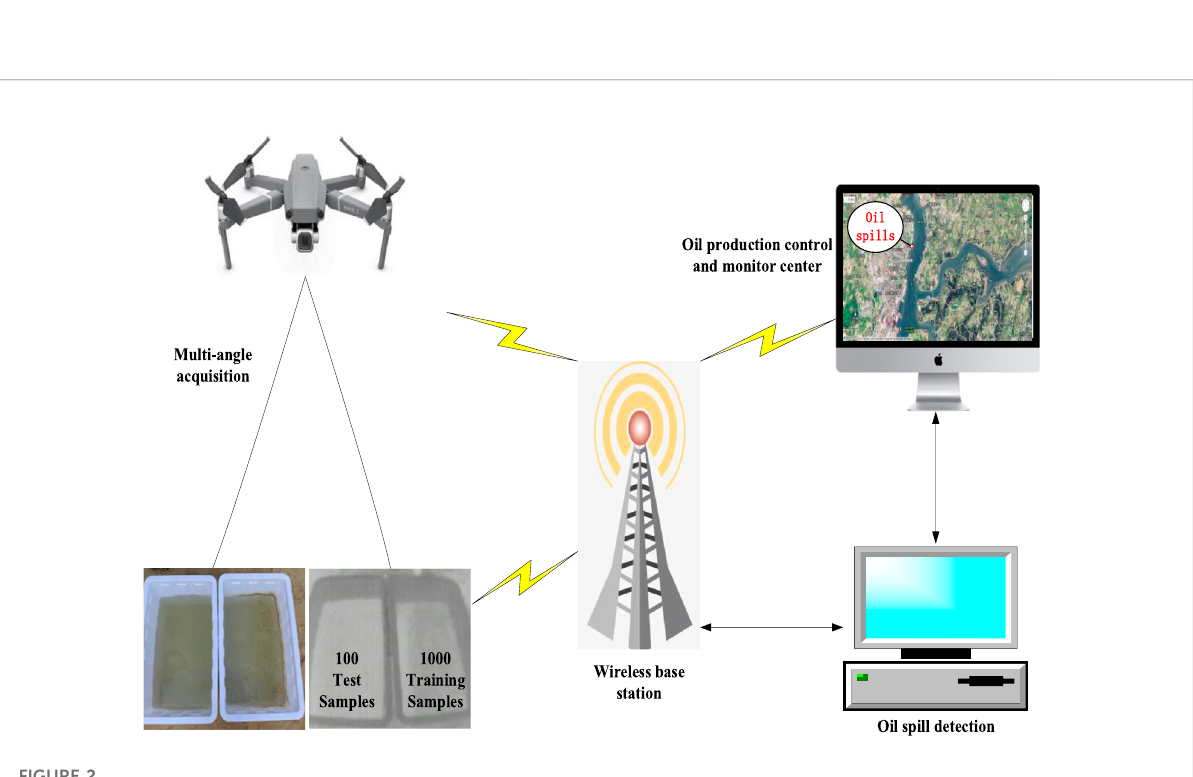
FIGURE 2 Collection process of oil spill